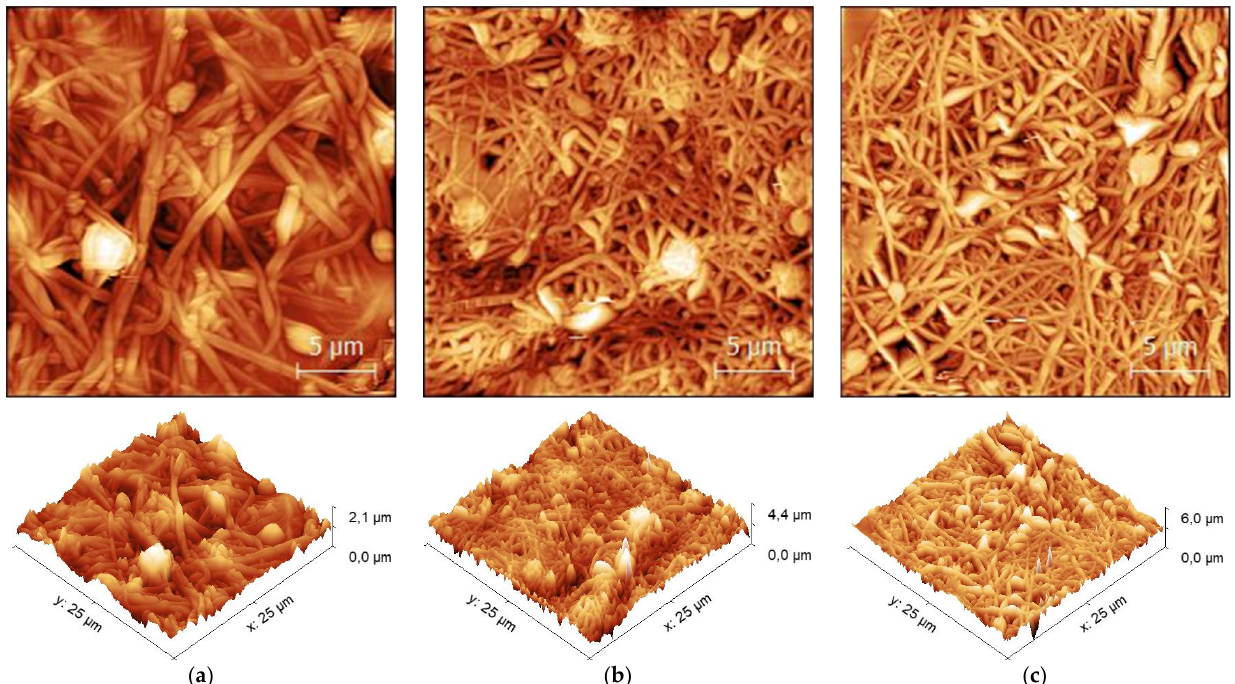
Figure 4. Atomic Force Microscope (AFM) micrographs of ( a ) PAN/magnetite nanofiber mat after electrospinning, ( b ) stabilized at 280 °C, and ( c ) carbonized at 600 °C. The scale bars indicate 5 μ m.